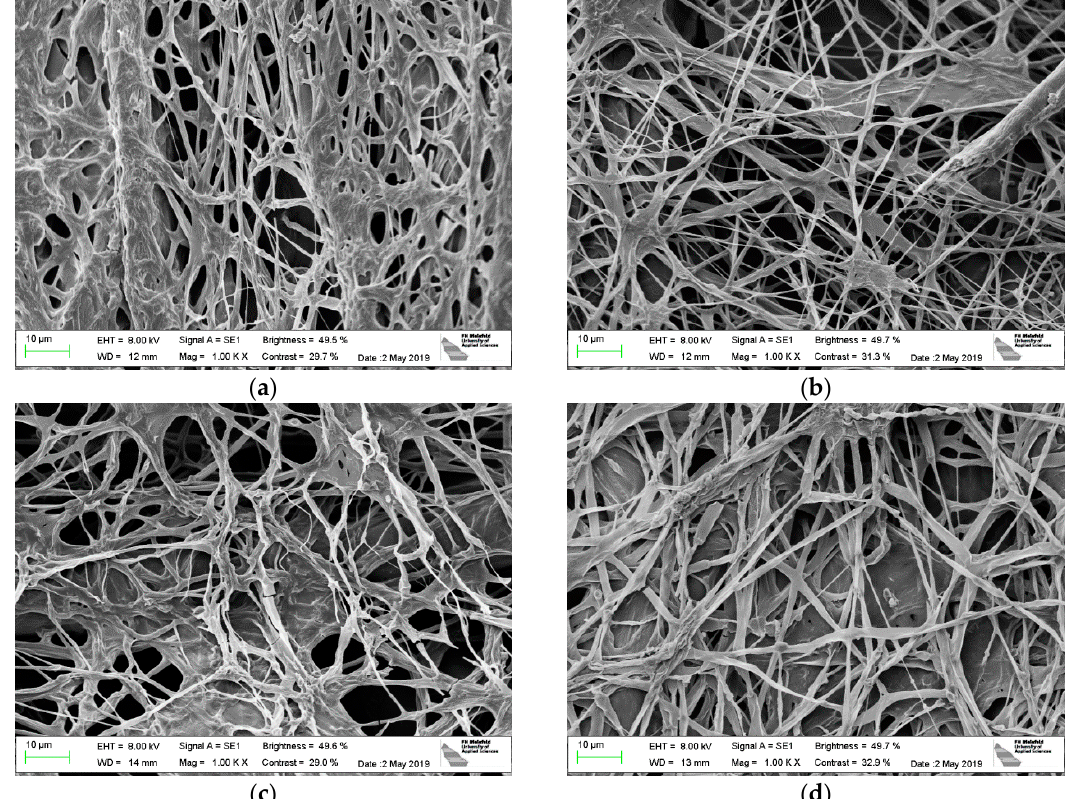
Figure 7. Scanning electron microscope (SEM) images of Pleurotus ostreatus mycelium on dip-coated substrates from different materials, knitted with stitch size 6: ( a ) cotton; ( b ) cotton/linen; ( c ) acrylic/wool; ( d ) acrylic.